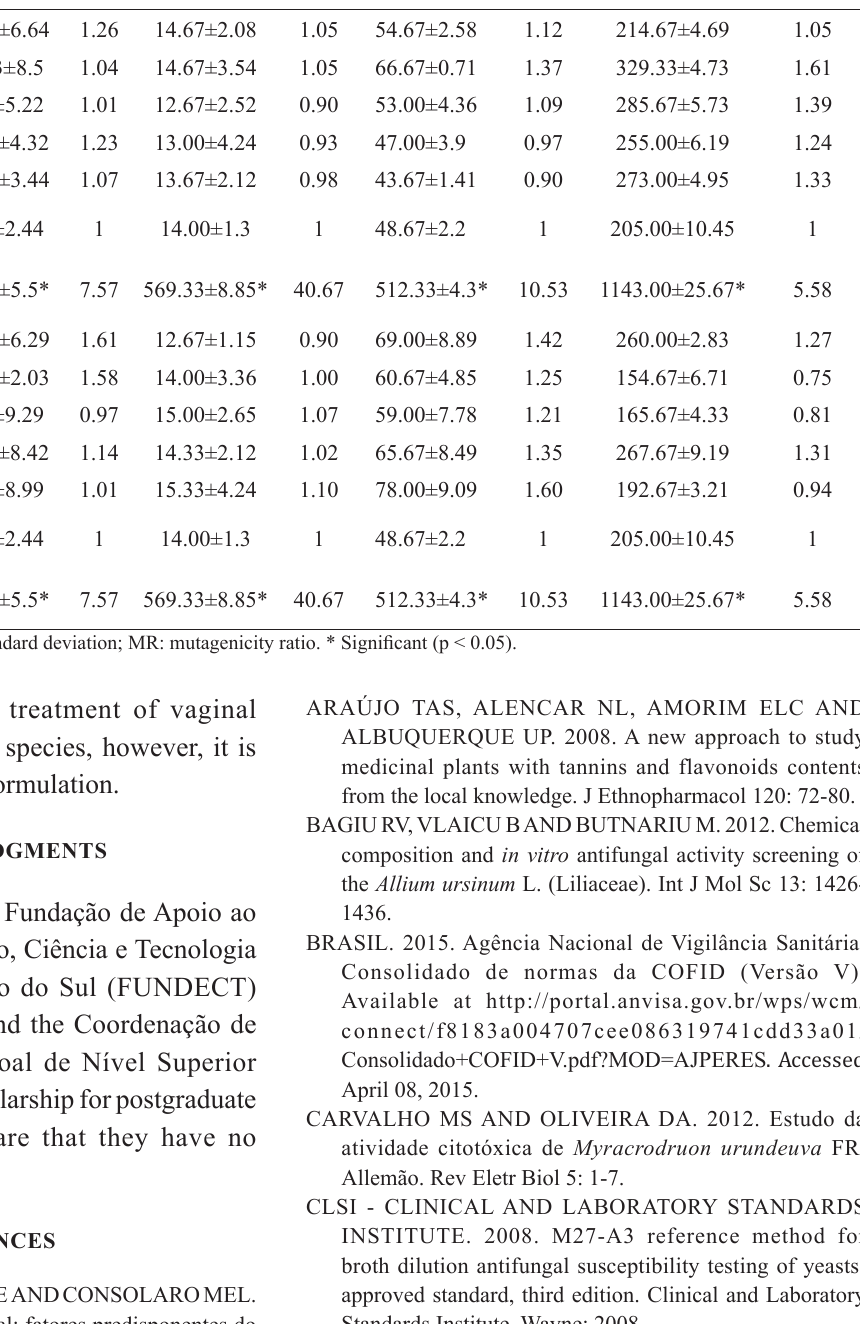
The number of revertant colonies and mutagenicity ratio of the different treatments of ethanol bark extract and ethanol leaves extract of M. urundeuva in S. Typhimurium strains (TA97a, TA98, TA100, and TA102).